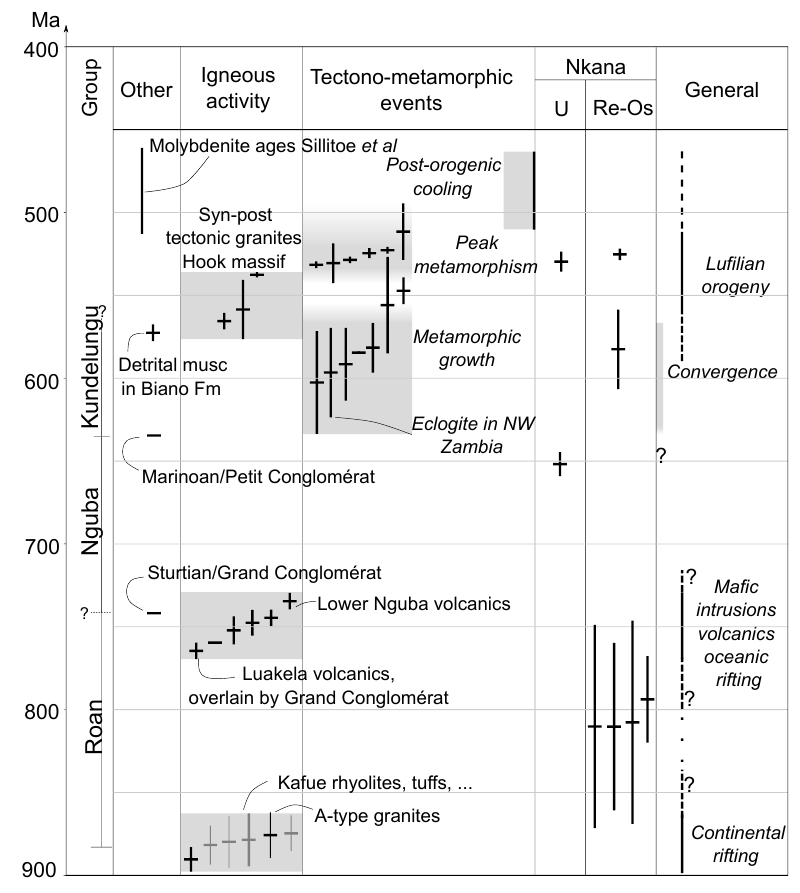
Figure 3. Selected age constraints on tectono-metamorphic events before, during and after deposition of the Katanga Supergroup with interpretation of the major events. Age data are shown with error of 2 σ and compiled from Barra et al. (2004), Barra (2005), Muchez et al. (2015) and Eastern Zambian Copperbelt data in Sillitoe et al. (2017) for Re–Os dating; Decrée et al. (2011) for U–Pb dating; Cosi et al. (1992), Hanson et al. (1993), Key et al. (2001), Barron et al. (2003), John et al. (2004), Master et al. (2005); Rainaud et al. (2005b), Armstrong et al. (2005) and Johnson et al. (2005) for various igneous and tectono-metamorphic events and Frimmel et al. (2011) for the timing of the Petit and Grand Conglomérat. The base of the Nguba and Kundelungu groups are defined by the base of the Grand Conglomérat and the Petit Conglomérat respectively. An overview of the data and references used in this figure is shown in the